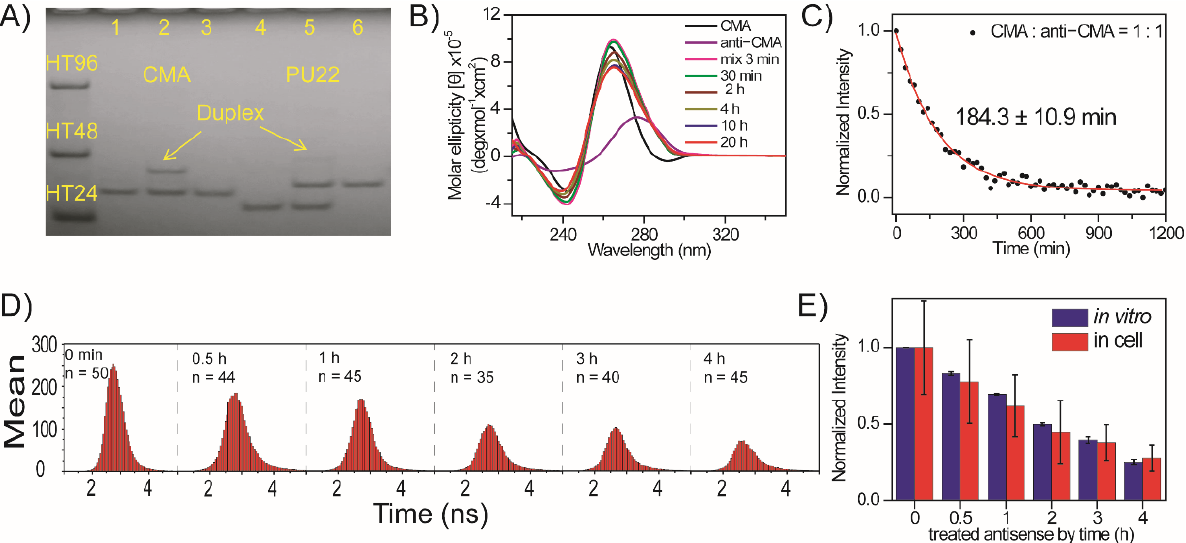
Figure 5. Imaging study of folding and unfolding of exogenous CMA in live CL1-0 cells. ( A ) Polyacrylamide gel electrophoresis assays of marker bands of HT24 (T 2 AG3) 4 , HT48 (T 2 AG 3 ) 8 , and HT96 (T 2 AG 3 ) 16 and CMA G4s (lane 1), CMA G4s after the addition of anti-CMA overnight (lane 2), anti-CMA (lane 3), PU22 G4 (lane 4), PU22 G4 after addition of anti-PU22 overnight (lane 5), and an- ti-PU22 (lane 6). ( B ) CD spectra of CMA and anti-CMA together with their mixture at different